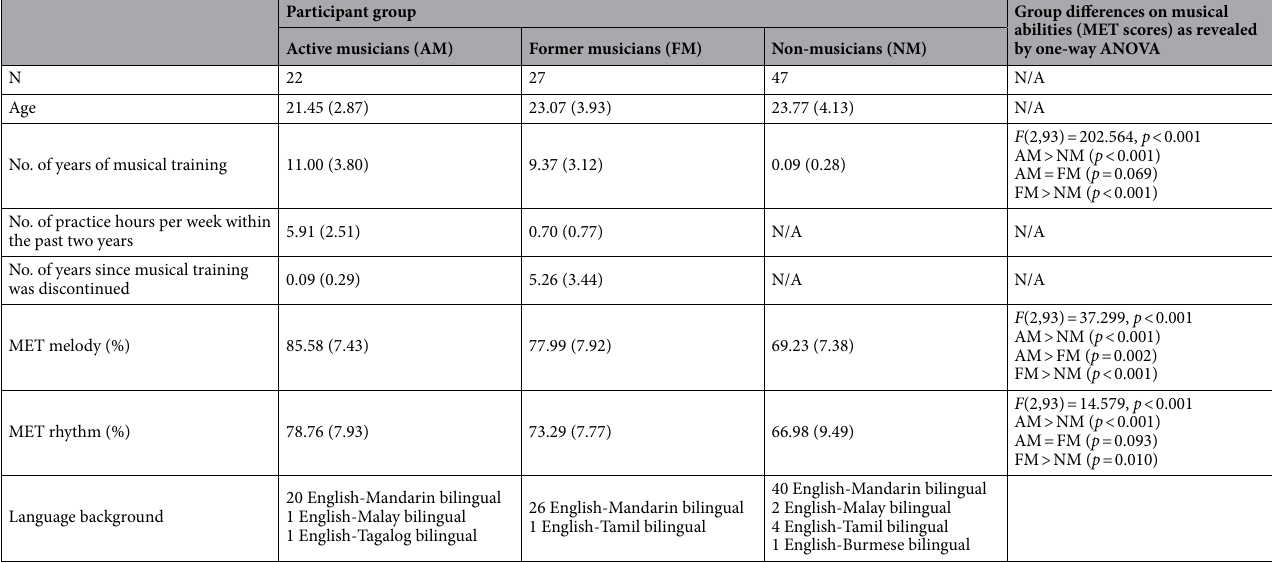
Table 1. Participant group demographics. Mean values and standard deviations (in parentheses) are given for age, musical background, and musical abilities. For the group differences on musical abilities, one-way ANOVA and pairwise comparisons are Bonferroni